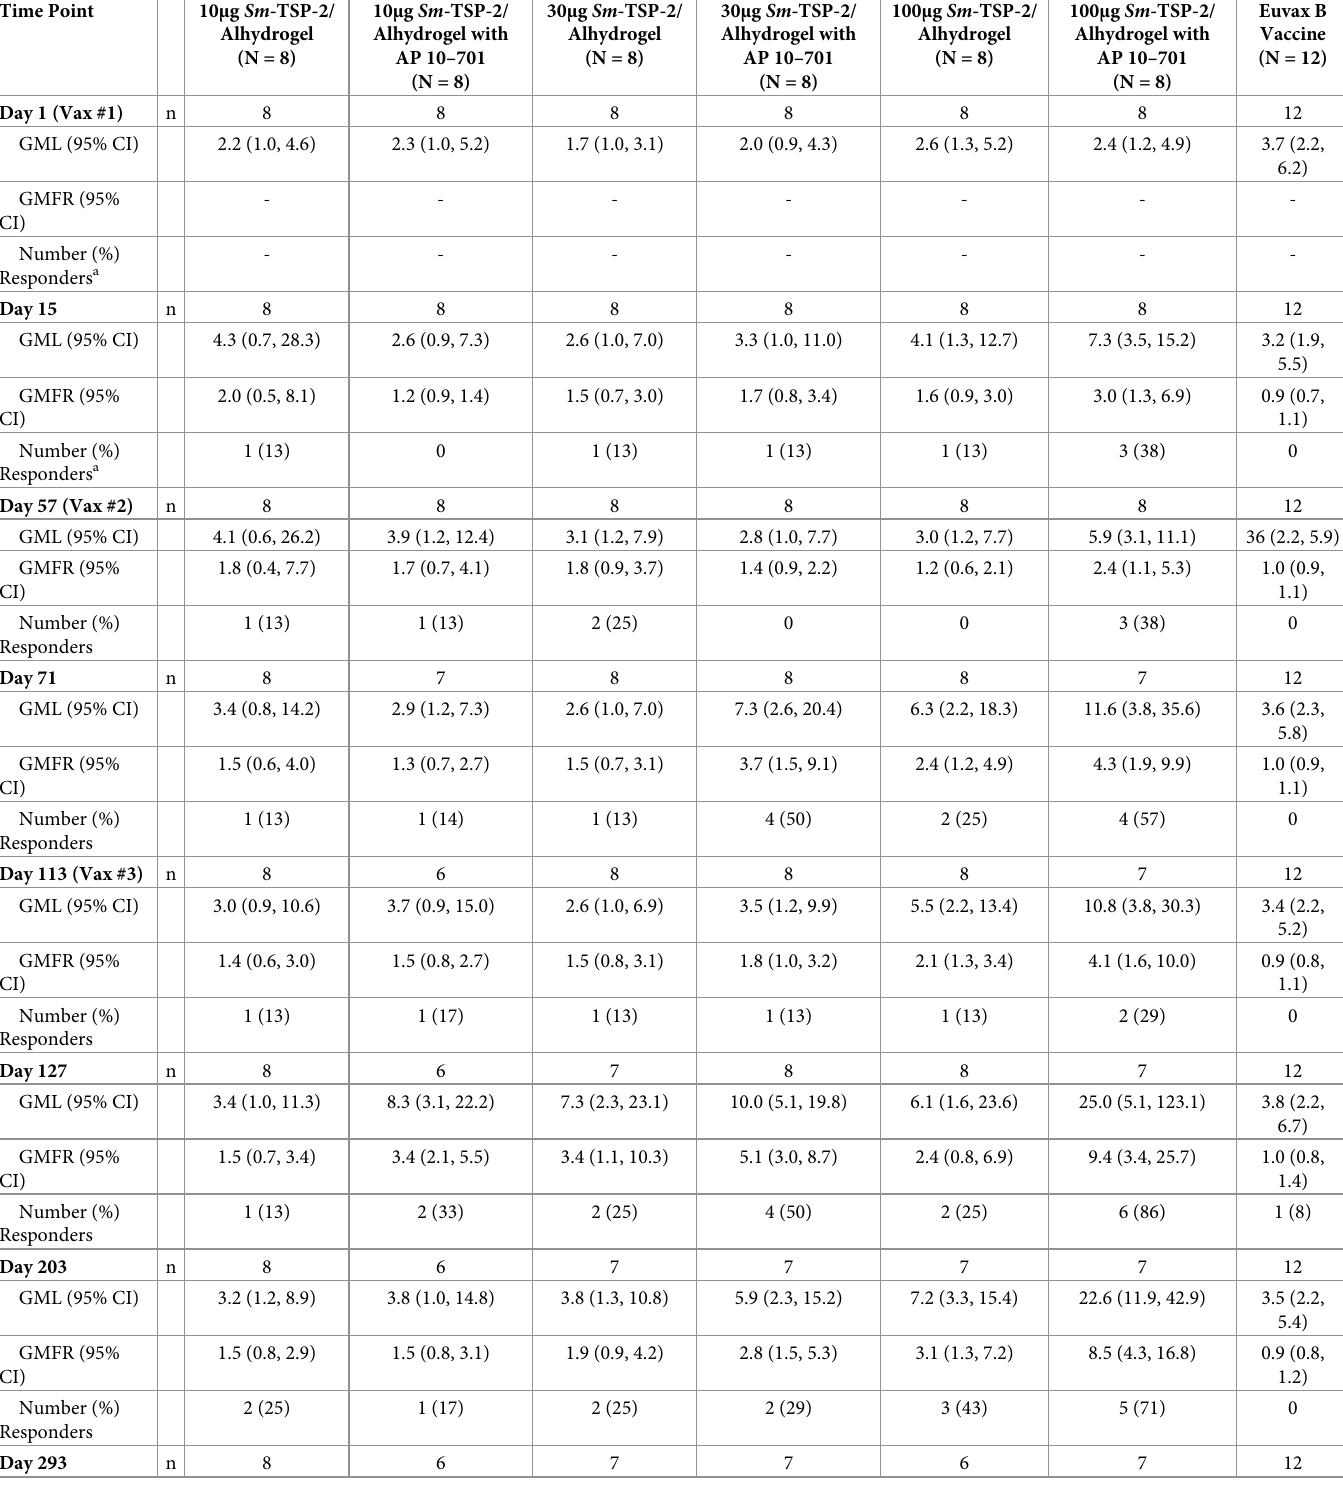
Table 2. Anti- Sm- TSP-2 total IgG geometric mean levels (Arbitrary Units) and seroresponse results, by time point and vaccine group (per-protocol immunogenic- ity